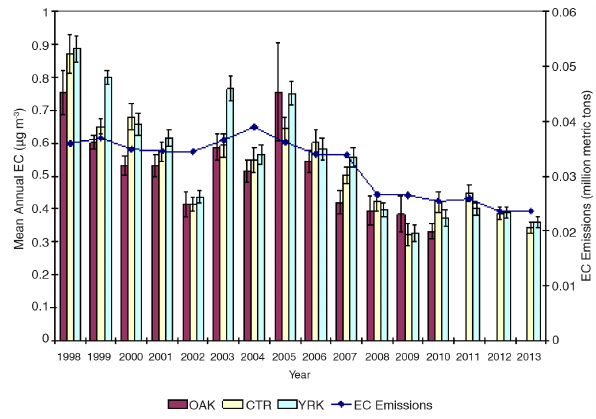
Figure 10. Mean annual EC concentrations at rural SEARCH sites compared with emissions of EC from all emission sources in Al- abama, Georgia, Mississippi, and northwest Florida. Emissions data are from extension using the method of Blanchard et al.